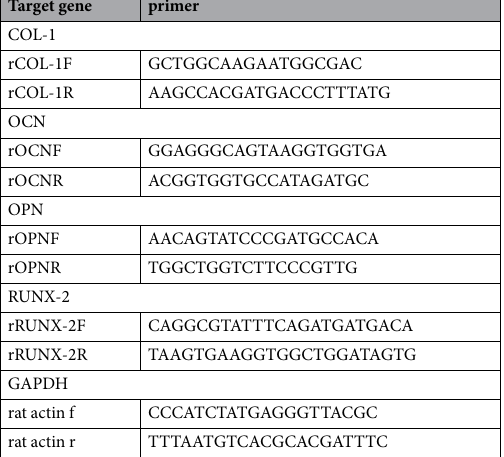
Quantitative real-time polymerase chain reaction. Quantitative real-time polymerase chain reaction analy- sis (qRT-PCR) was performed to examine the expression of various osteogenic factors, including runt-related transcription factor 2 (Runx2), osteocalcin (OCN), osteopontin (OPN), and collagen type I (COL-1) (shown in Table 1). After incubation with the disk-shaped PT, T-3, T-10 and T-12.5 samples for 3, 7, and 14 days, the